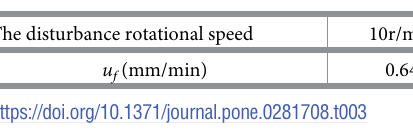
Table 3. Parameters of different disturbance forces.